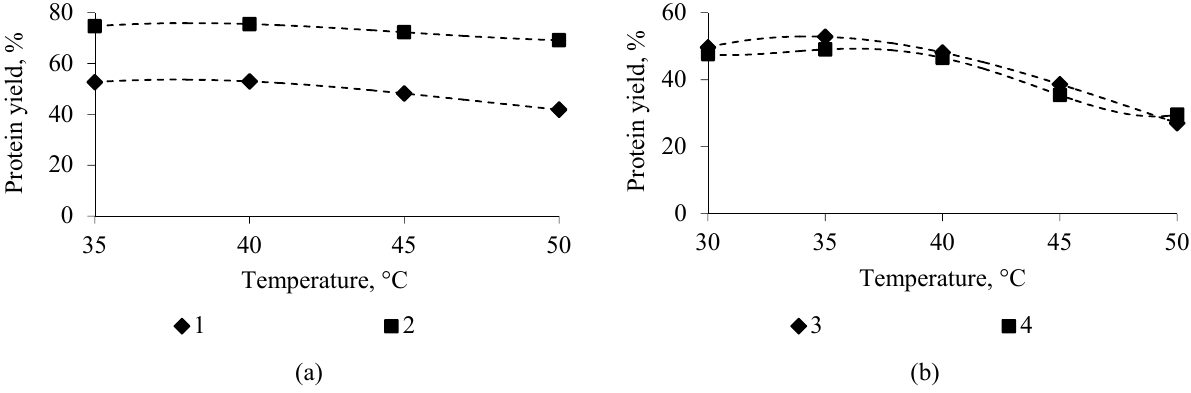
Fig. 9. Temperature effect of the process of alkaline (a) and acid (b) extraction on the yield of protein substances from the oat grains of the Rysak variety in the presence of: (1) 1 M of a potassium hydroxide solution; (2) 1 M of a sodium hydroxide solution; (3) of an aqueous hydrochloric acid solution; (4) of an aqueous sulfuric acid